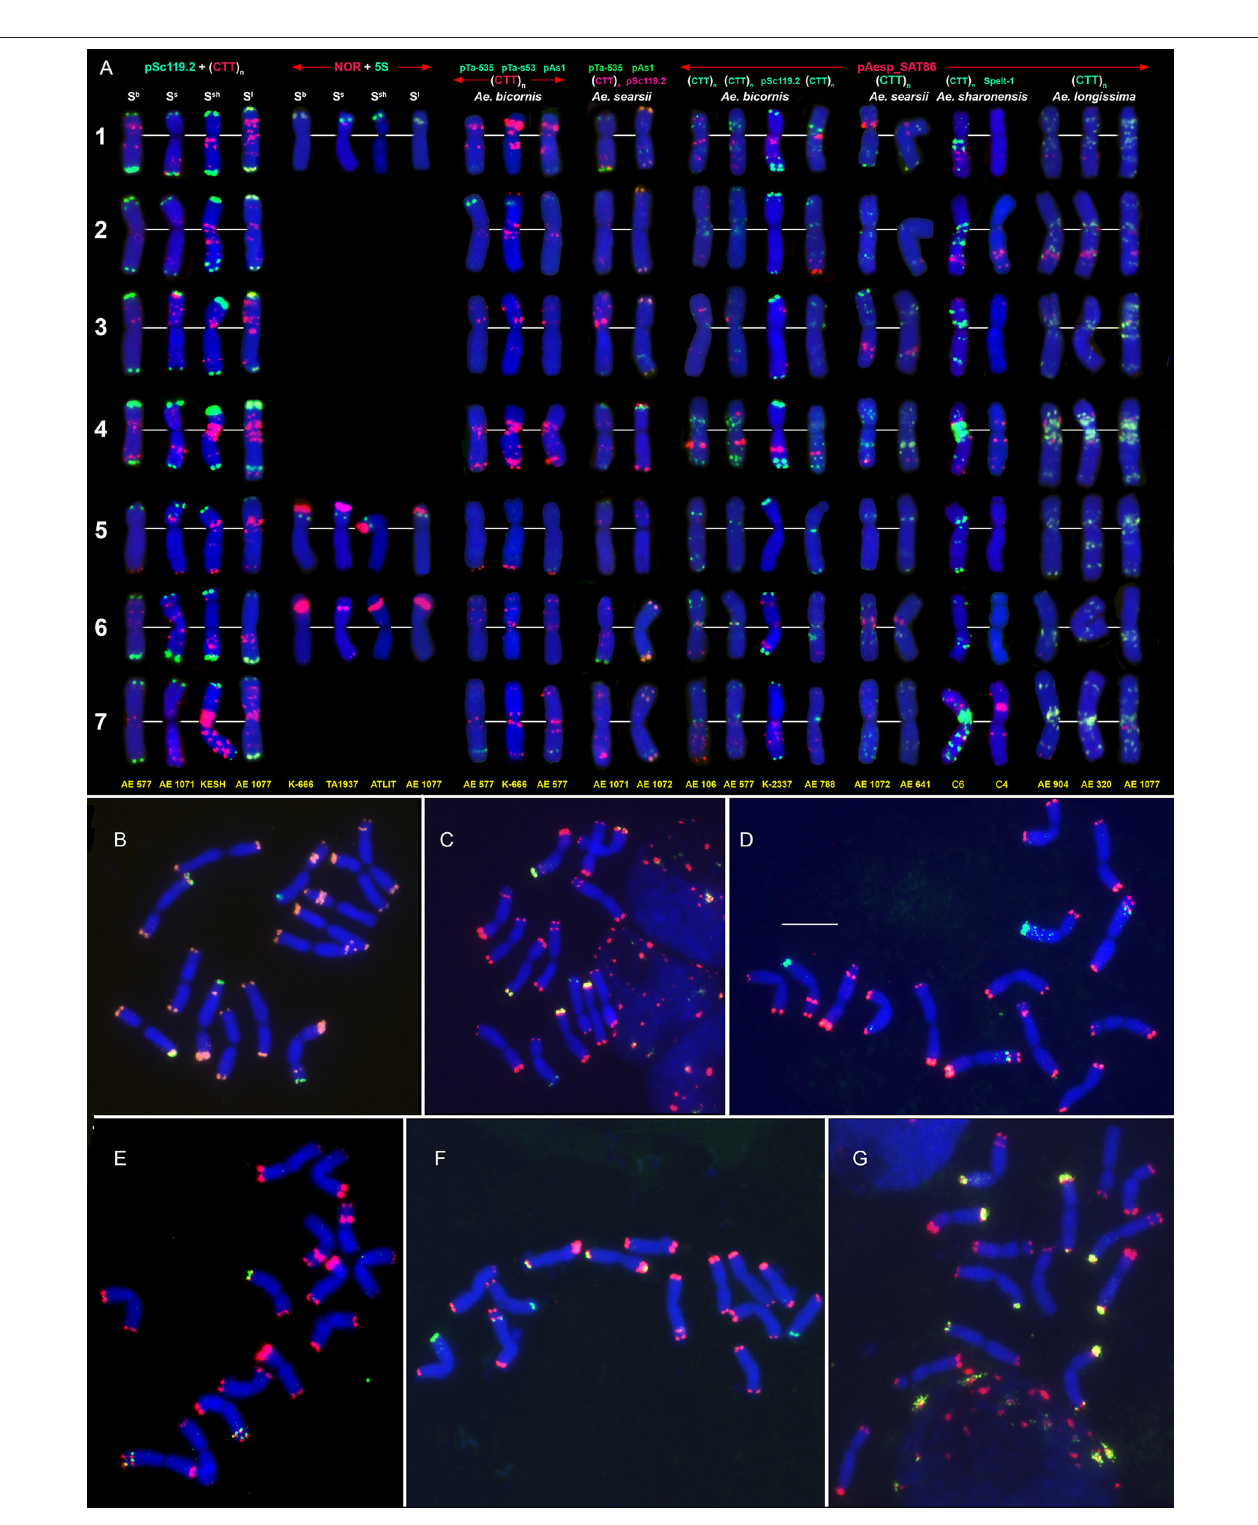
FIGURE 4 | Distribution of repeated DNA sequences on chromosomes of four species of Emarginata group (A) , Ae. bicornis (S b ), Ae. searsii (S s ), Ae. sharonensis (S sh ), and Ae. longissima (S l ). (A) Probe combinations are given on the top, accession names are shown below karyograms. Signal color corresponds to probe name. 1–7 – homoeologous groups. Polymorphisms of Spelt-52 patterns on Ae. longissima (B–D) and Ae. sharonensis (E–G) chromosomes: (B) , K-905; (C) , K-907; (D) , C3 (HaBonim); (E) , C6 (Keshon); (F) , C7 (HaBonim); (G) , i-570030. The pSc119.2 signals are shown in red, Spelt-52–in green. Scale bar, 10 µ m.